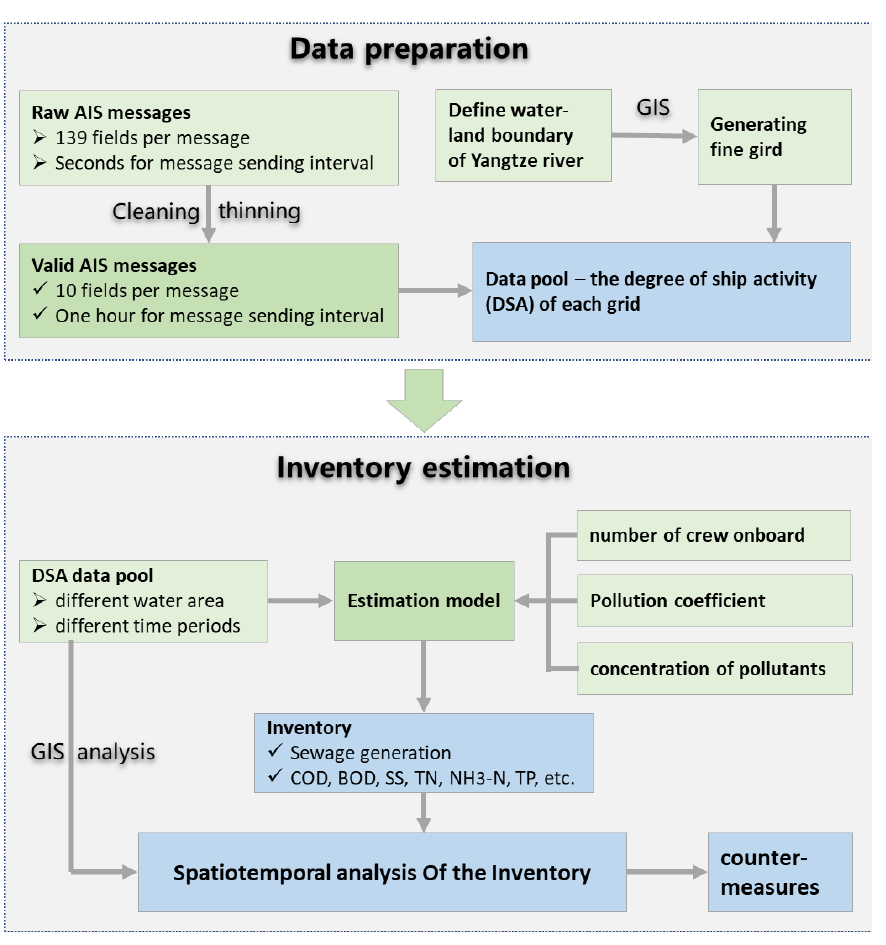
Figure 2. The procedure for the establishment of the inventory.